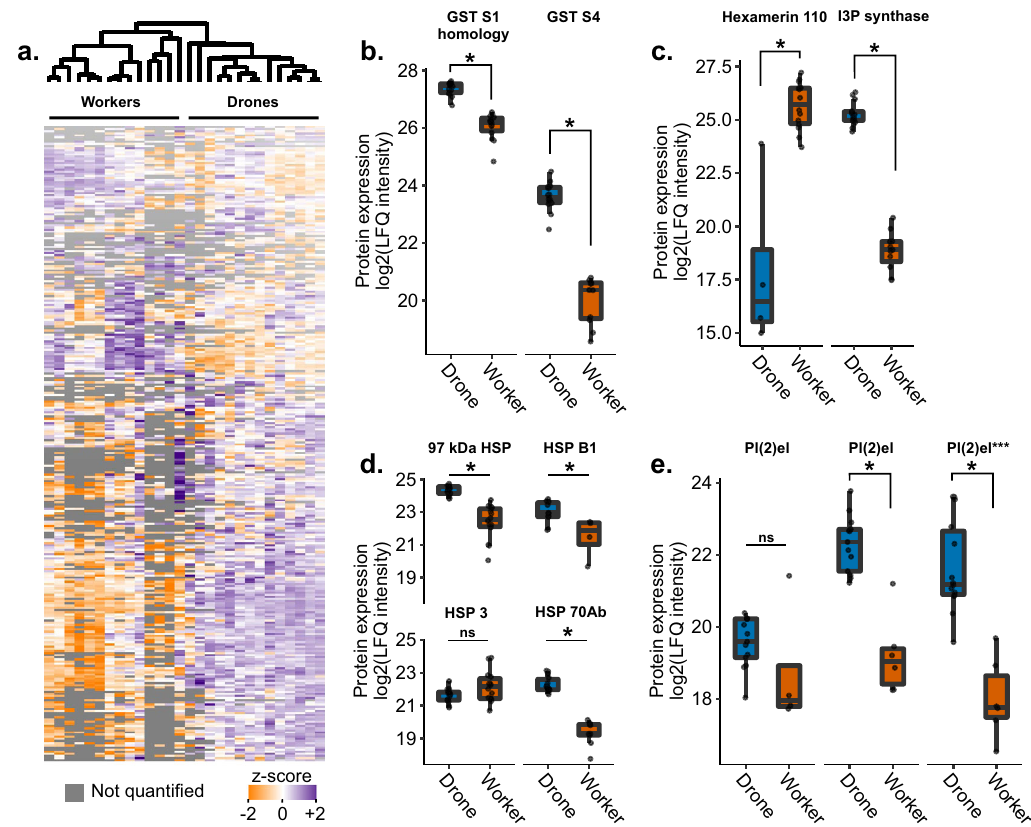
Fig. 6 Comparing untreated drones and workers. Boxes represent the interquartile range, bars indicate the median, and whiskers span 1.5 times the interquartile range. a Quantitative proteomics identi fi ed 2,089 proteins in the hemolymph of n = 14 drones and n = 14 workers, with 988 quanti fi ed after quality fi ltering. b – e 483 proteins were differentially expressed (two group comparison, Benjamini – Hochberg correction at 5% FDR), with proteins of interest highlighted here. e Several proteins share the name protein lethal(2) essential for life-like (pl(2)el), and the speci fi c pl(2)el, which was depicted in Fig. 4d is highlighted by three asterisks here. Underlying proteomics data are available in Supplementary Data